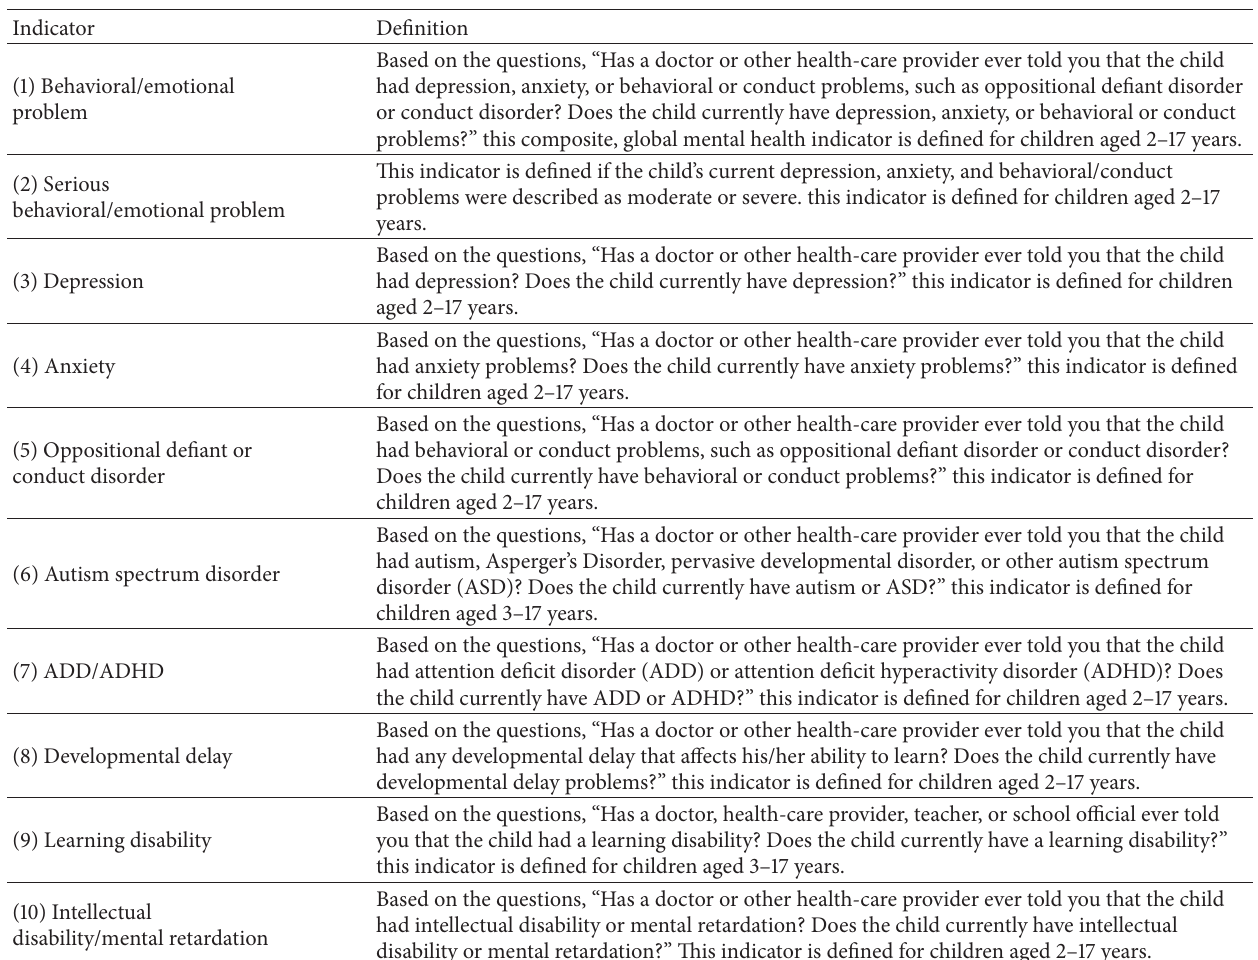
Table 1: Definitions of selected mental health indicators in the 2011-2012 National Survey of Children’s